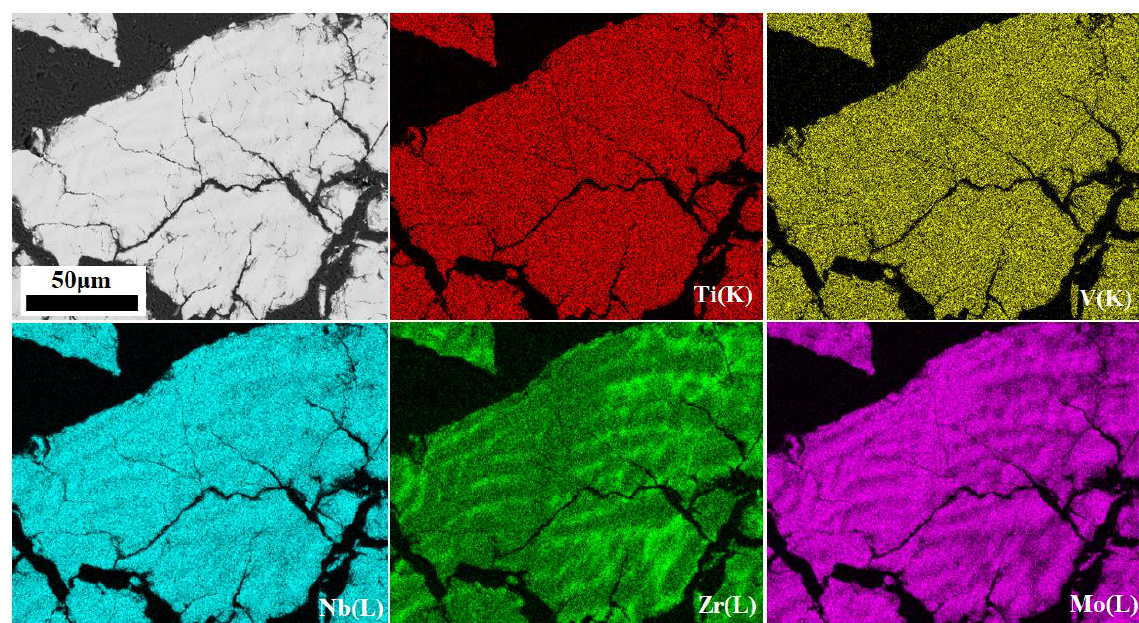
Figure 9. BSE image and EDS mapping analysis of Ti 0.30 V 0.25 Zr 0.10 Nb 0.25 Mo 0.10 alloy after 20 hydrogen absorption/desorption cycles.